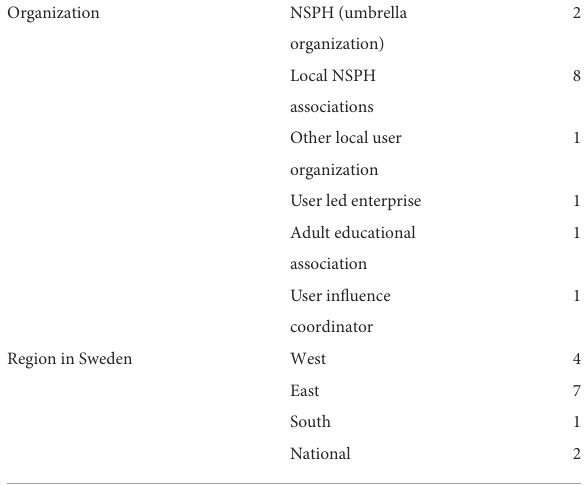
TABLE 2 User movement representatives–workshop II ( N =